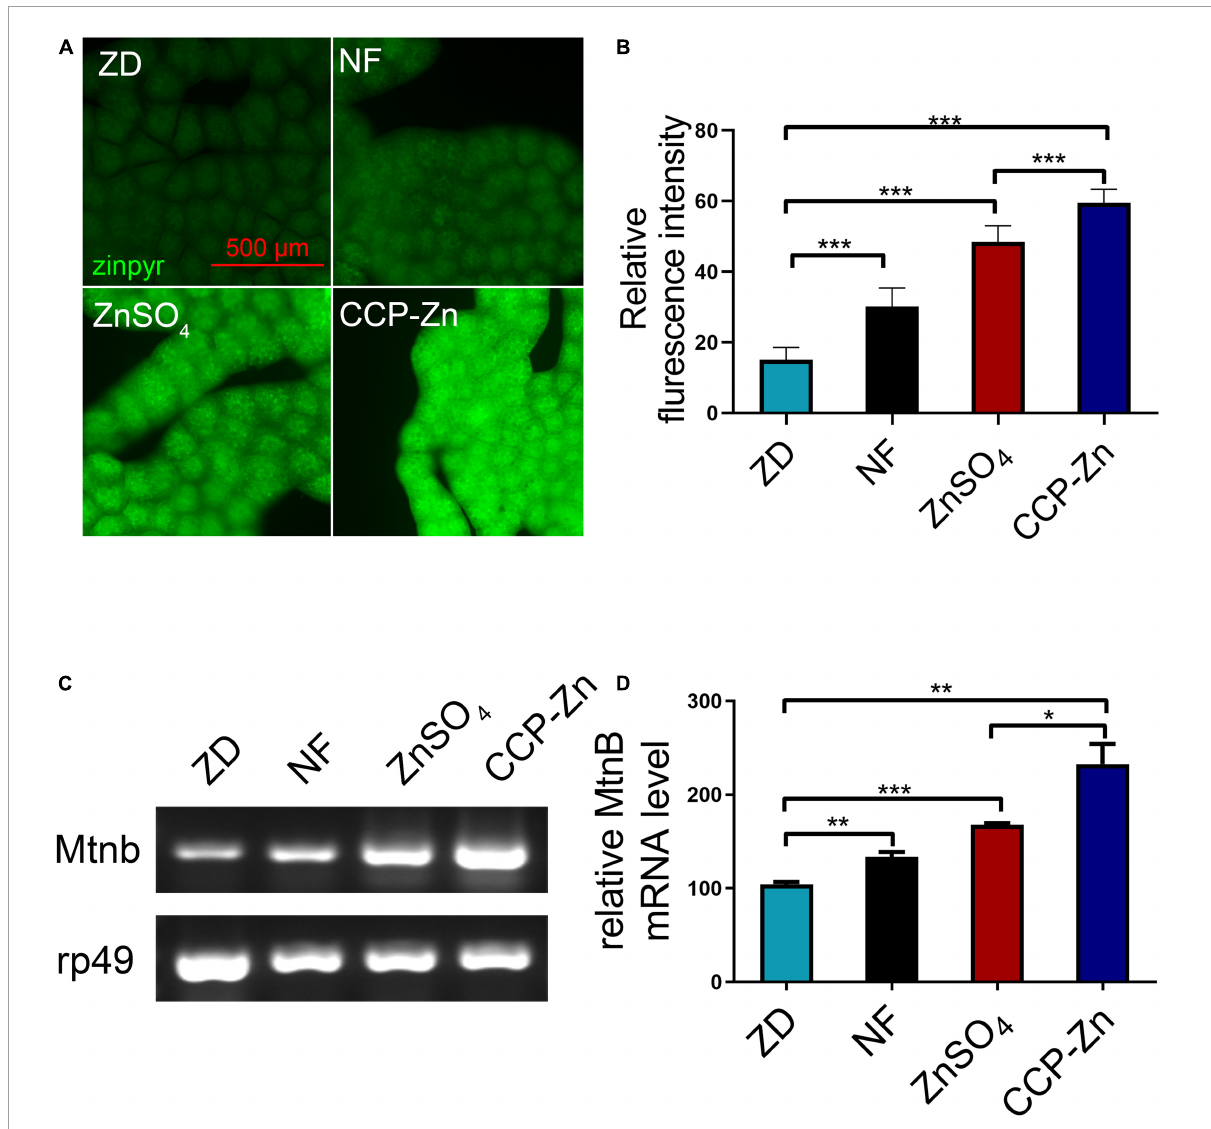
FIGURE4 The bioavailability of CCP–Zn is higher than ZnSO 4 . (A) Zinpyr-1 staining showed that the zinc levels in the fat body of Drosophila raised on CCP–Zn is higher than flies raised on CCP–Zn (1.28 g/L) or ZnSO 4 (3 mM), n = 10. (B) Quantitative measurement of the fluorescent signals in (B) . (C) RT-PCR analysis indicated that MtnB mRNA levels in the whole body of Drosophila raised on CCP–Zn (1.28 g/L) are higher than flies raised on ZnSO 4 (3 mM), n = 10. (B,D) Quantitative measurement of (C) . Data are represented as mean ± SEM of the biological replicates. * p < 0.05, ** p < 0.01, *** p < 0.001; two-tailed Student’s t